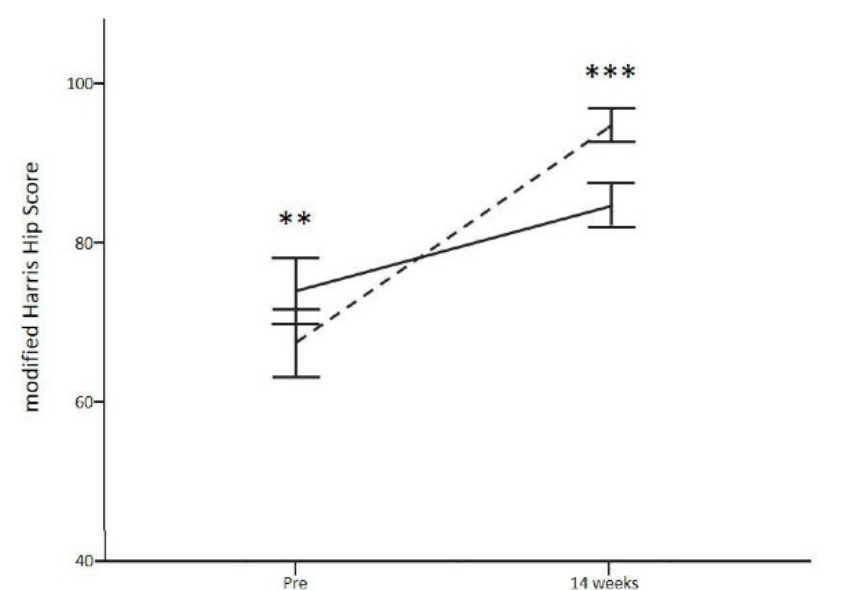
Figure 2. Functional status and interference in the activities of daily life were evaluated by mHHS. ** p < 0.01; *** p < 0.001 vs. control group.